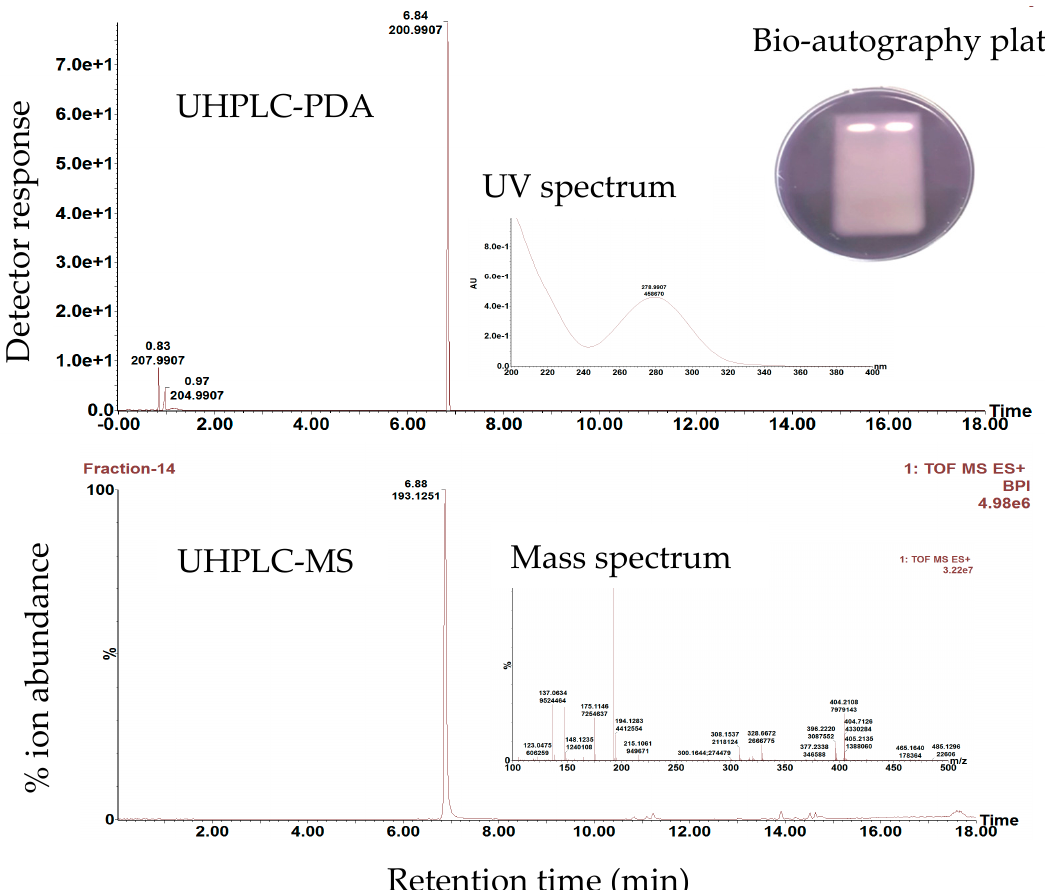
Figure 3. Ultra performance liquid chromatography (UHPLC)-photodiode array (PDA) and UHPLC-mass spectrometry (MS) chromatograms of sedanenolide, isolated from the ethyl acetate crude extract of Apium graveolens. The ultraviolet absorbance spectrum and mass spectrum are also provided. The high performance thin layer chromatography (HPTLC)-bio-autography plate of pure sedanenolide (in duplicate) against Chromobacterium violaceum is also indicated with the white zones confirming the anti-quorum sensing activity of the compound.